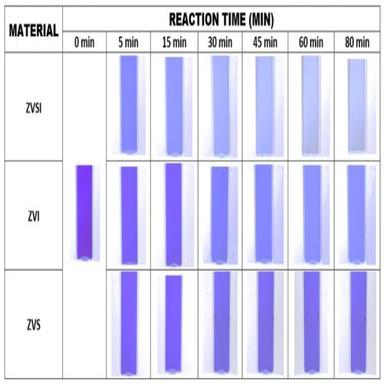
Visual evolution of BPB during degradation